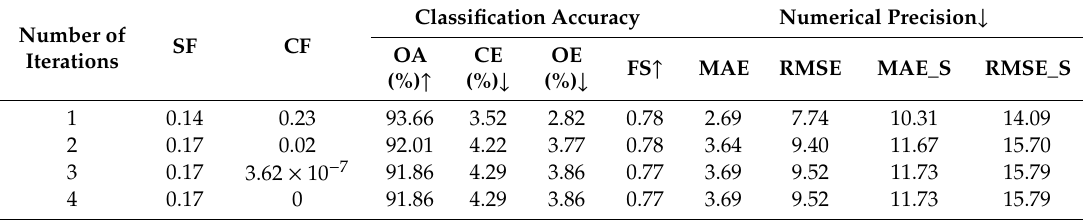
Table 4. The relation between the number of iterations and the accuracy of cloud